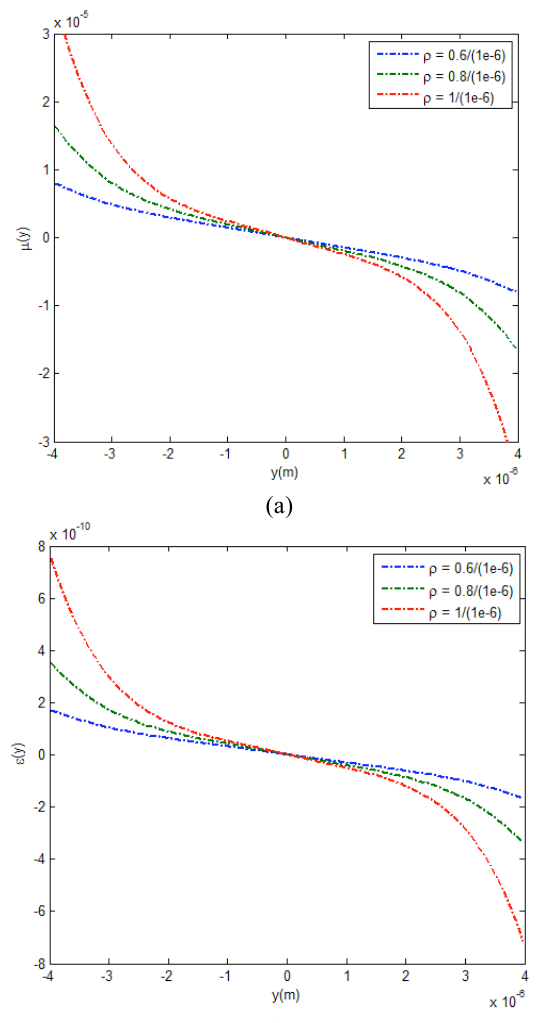
Figure 1: (a) permeability in hyperbolic function (b) permittivity in hyperbolic